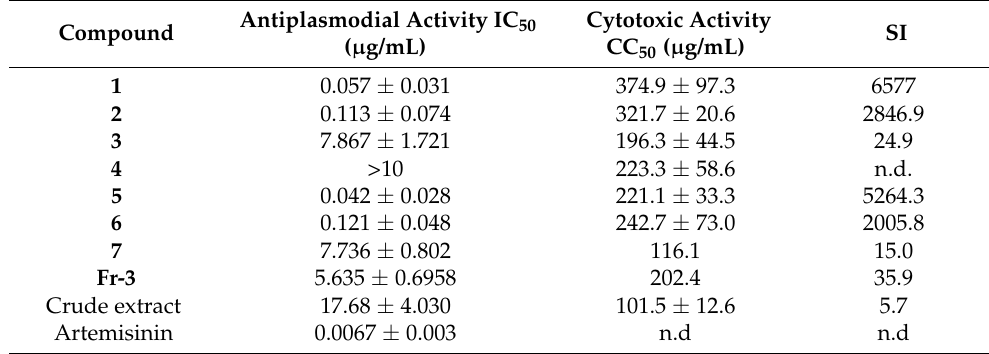
Table 1. In vitro antiplasmodial activity of the crude extract and isolated compounds on the well-known 3D7 chloroquine-sensitive strain of P. falciparum , their THP-1 cell cytotoxicity and selectivity indices (SI). Compound